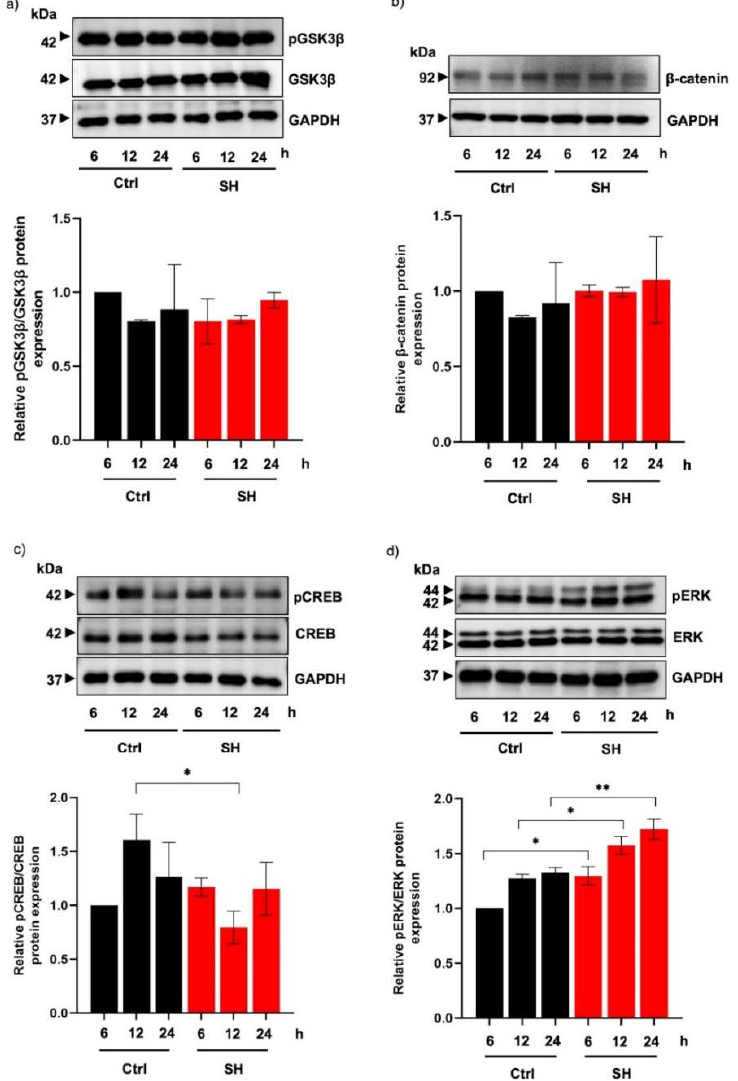
Figure 6. MITF-regulating proteins modulated by sericin hydrolysates prepared by Alcalase ® ( a , b ). Although there was no alteration of protein involving GSK3 β / β -catenin cascade, ( c ) the decreased expression of pCREB/CREB indicated the restraint on upstream signal regulating MITF